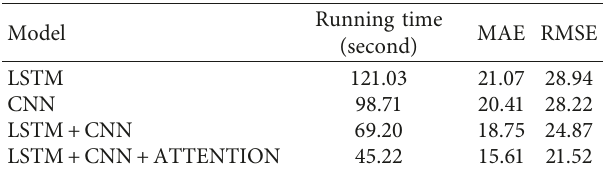
Figure 6: Traffic flow prediction under CNN-LSTM model. Table 2: Analysis of experimental